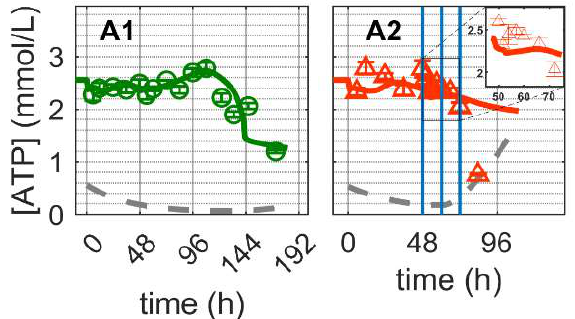
Figure 1. Dynamics of cell growth in mock-infected and infected suspension MDCK cells . ( A 1, A 2) Figure 3. Dynamics of extracellular substrates and metabolic by-products in mock-infected and in- Figure 6. Dynamics of ATP in mock-infected and infected suspension MDCK cells. ( A 1, A 2) Adeno- Viable cell concentration, ( B 1, B 2) mean cell diameter and ( C 1, C 2) total volume of viable cells. Data fected suspension MDCK cells. ( A 1, A 2) Glucose, ( B 1, B 2) lactate, ( C 1, C 2) glutamine, ( D 1, D 2) sine tri-phosphate (insert: 48–72 h of infected cultivation). Data and error bars represent the mean sine tri-phosphate (insert: 48–72 h of infected cultivation). Data and error bars represent the mean and error bars represent the mean and standard deviation of technical triplicates for two independ- ammonium, ( E 1, E 2) pyruvate, and ( F 1, F 2) glutamate. Data and error bars represent the mean and and standard deviation of technical triplicates for two independent experiments (mock-infected Θ ent experiments (mock-infected Θ and infected ∆). Lines: model simulations. Vertical blue lines cor- and standard deviation of technical triplicates for two independent experiments (mock-infected standard deviation of technical triplicates for two independent experiments (mock-infected Θ and and infected ∆). Lines: model simulations. Vertical blue lines correspond to (0, 12 and 24 h post respond to 0, 12 and 24 h post infection. Experimental data used for parameter estimation: A 1, B 1, infected ∆). Lines: model simulations. Vertical blue lines correspond to 0, 12 and 24 h post infection, ). Lines: model simulations. Vertical blue lines correspond to (0, 12 and 24 h post infection, respectively). The grey lines indicate the limit of quantification for each metabolite and C 1 (see Supplementary File S4 and S5). respectively. The grey dashed lines indicate the limit of quantification for each metabolite and grey infection, respectively). The grey lines indicate the limit of quantification for each metabolite and the grey data points are under the limit of quantification. Experimental data used for parameter data points are under the limit of quantification. Experimental data used for parameter estimation: the grey data points are under the limit of quantification. Experimental data used for parameter estimation: A 1 (see Supplementary File S4 and S5). A 1, B 1, C 1, D 1, E 1 and F 1 (see Supplementary File S4 and S5). estimation: A1 (see Supplementary Files S4 and